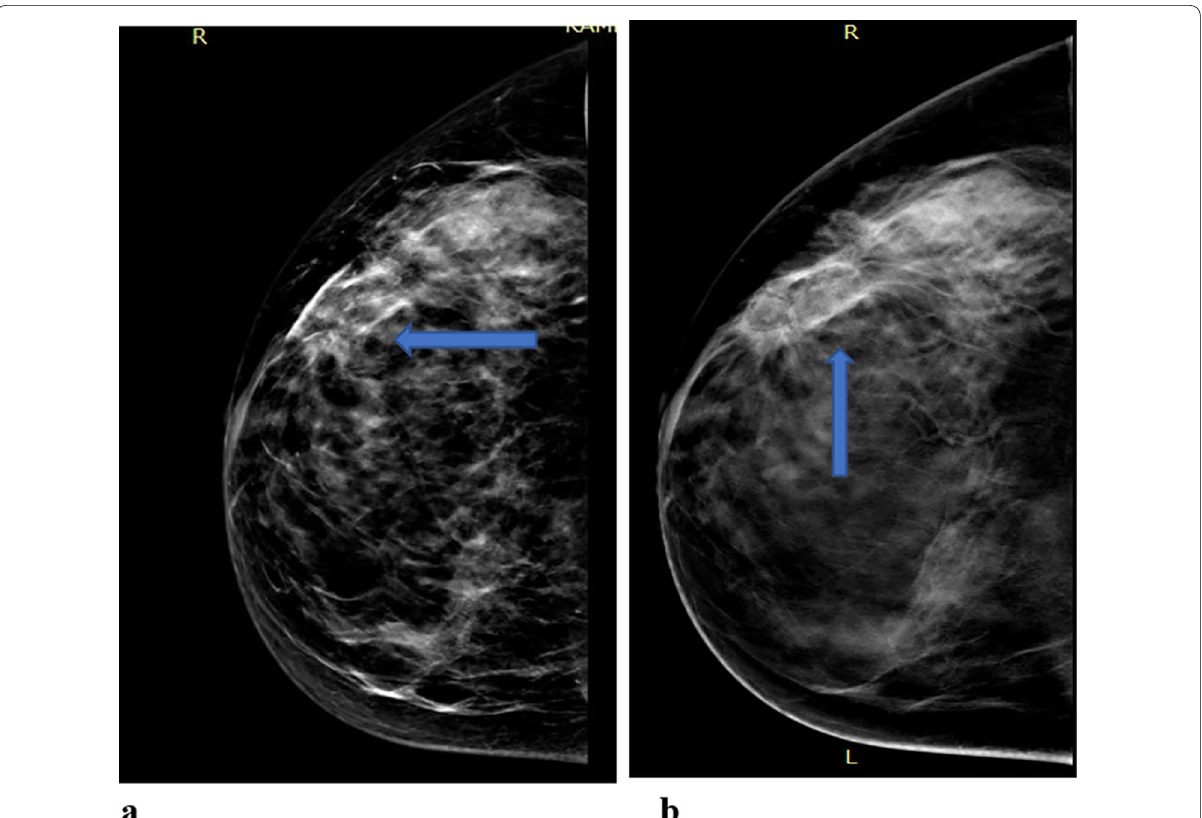
Fig. 8 A 31-year-old female came follow-up after right breast lumpectomy. a CC view of 2DDM of the right breast shows Scattered fibro-glandular densities (ACR b). b CC view of DBT of the right breast. Right breast shows irregular dense mass in outer quadrant in relation to radial scar with speculated margins best seen in DBT. BIRADS 5, proved by histopathology to be postoperative recurrent invasive ductal